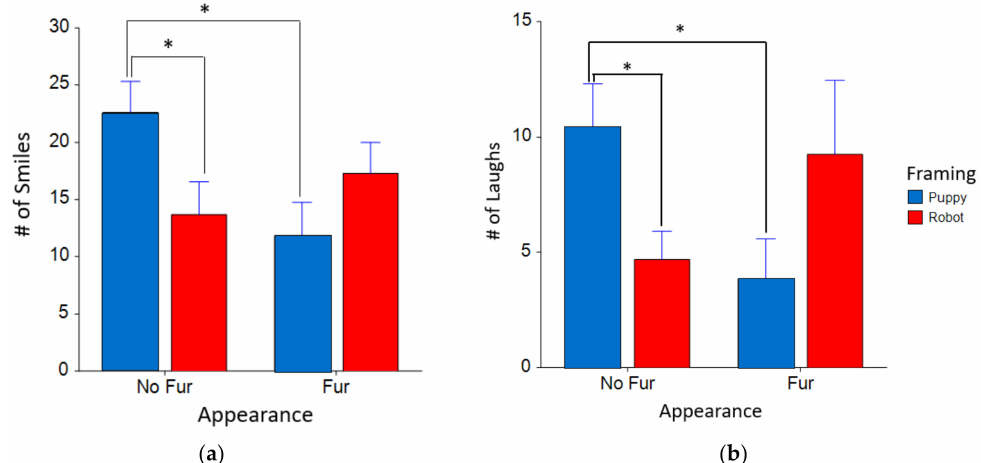
Figure 6. The number of times participants smiled and laughed based on Aibo behavior in interactive T-patterns across each framing and appearance condition. ( a ) Participants smiled at Aibo with puppy framing and no fur significantly more than puppy Aibo with fur and robot Aibo with no fur; ( b ) Participants laughed more while interacting with Aibo with puppy framing and no fur than puppy Aibo with fur; * p <